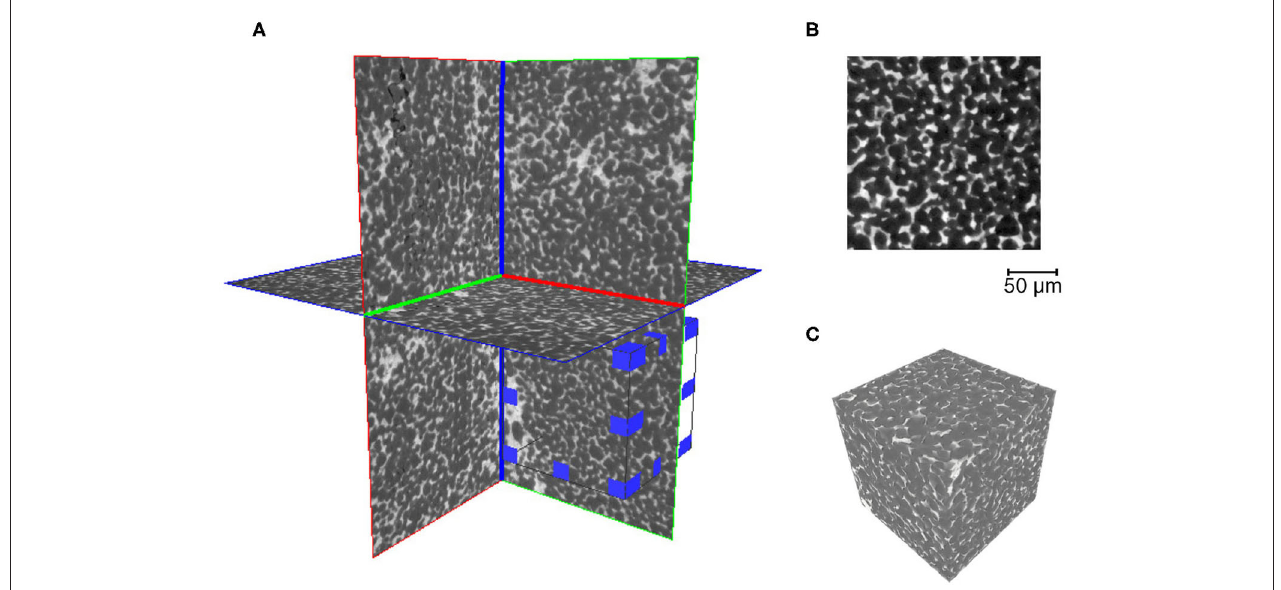
FIGURE 3 | Sub-sample selection figure. The whole volume for sample OFS-3 – is shown in (A) , with subvolume 2 highlighted by the small cube with blue marked edges. A 2D slice through the subvolume is displayed in (B) , and a 3D volume rendered image of the whole subvolume is shown in (C)